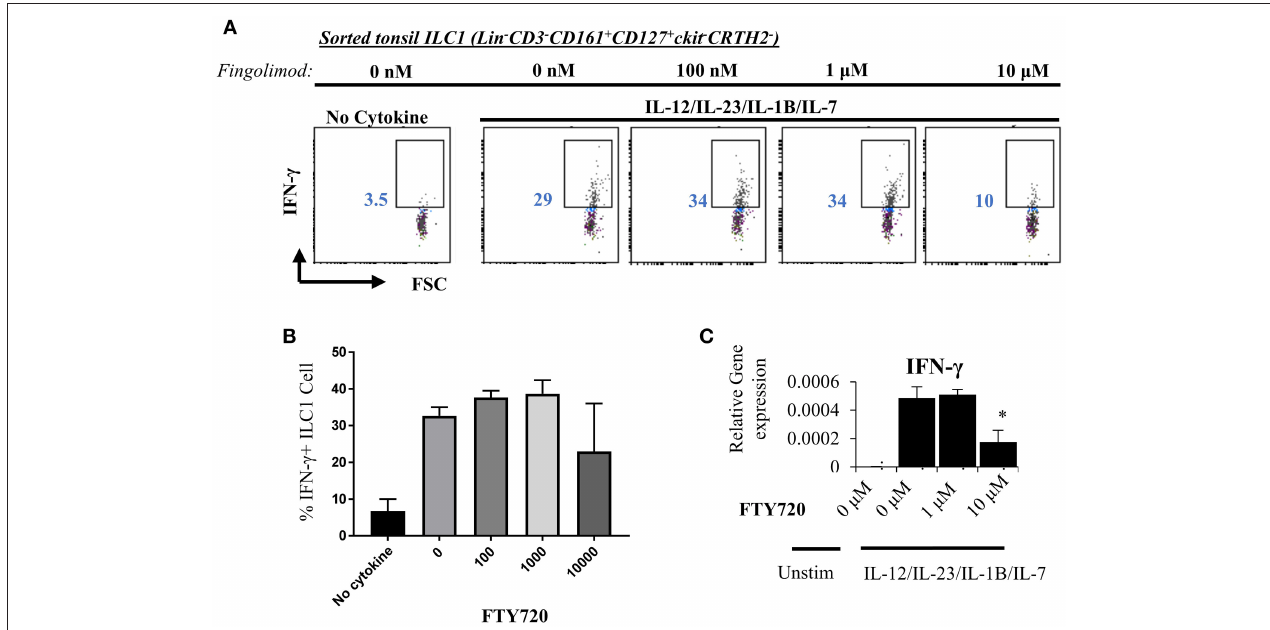
FIGURE 5 | Fingolimod does not alter IFN- γ production by ILC1 at low doses. (A) ILC1s sorted from tonsils (gated as Lin-CD3-CD161 + CD127 + ckit-CRTH2-) were cultured in charcoal stripped FBS-supplemented media containing IL-12/IL-23/IL-1B/IL-7, 20 ng each, with increasing concentrations of FTY70 for 3 days IFN- γ production was measured with intracellular staining ( A , a representative plot) and quantified (B) and mRNA levels were quantified via real time qPCR (C)